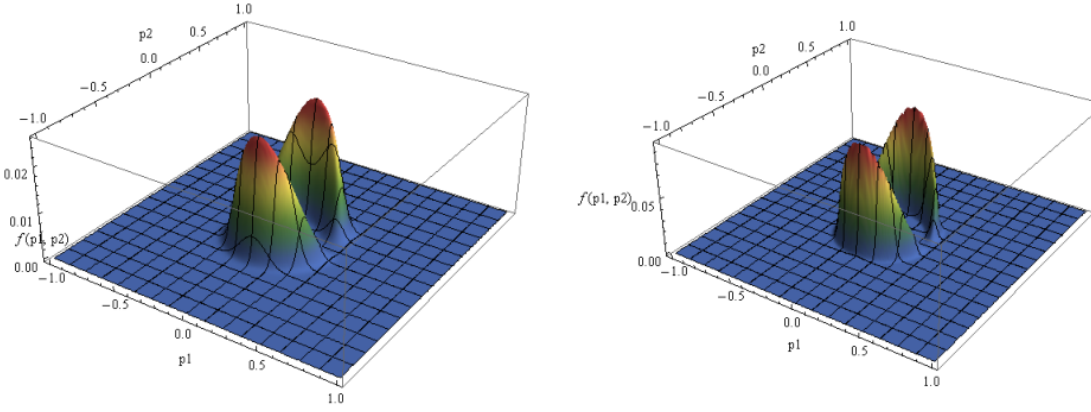
Figure 7. The residual distribution function in momentum space after the action of the electric field